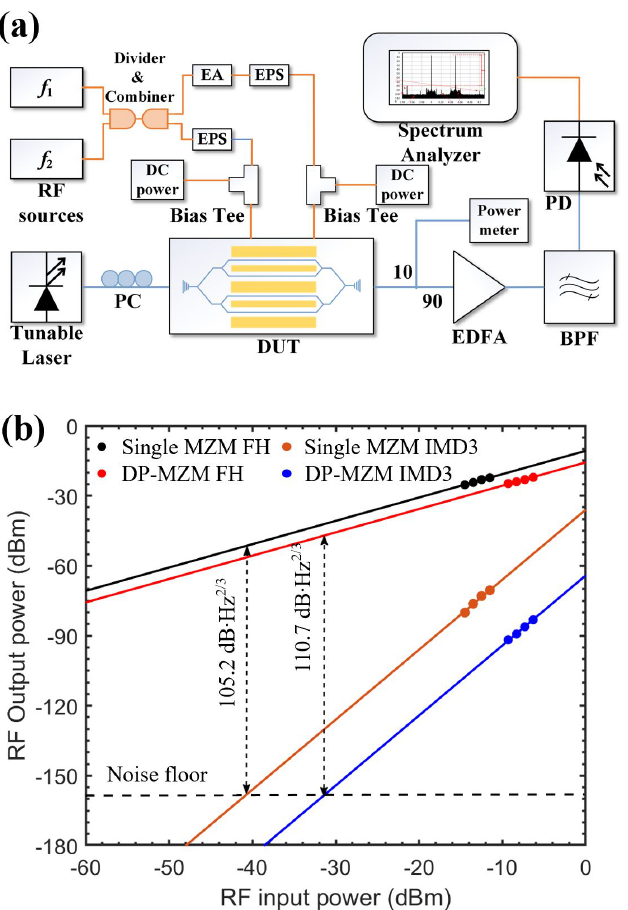
Figure 5. ( a ) Experiment setup of the two-tone test. PC: polarization controller; EA: electrical attenuator; EPS: electrical phase shifter; DUT: device under test; EDFA: erbium-doped fiber amplifier; BPF: band-pass filter; PD: photodiode. ( b ) Experimental SFDR results of the single MZM and the proposed